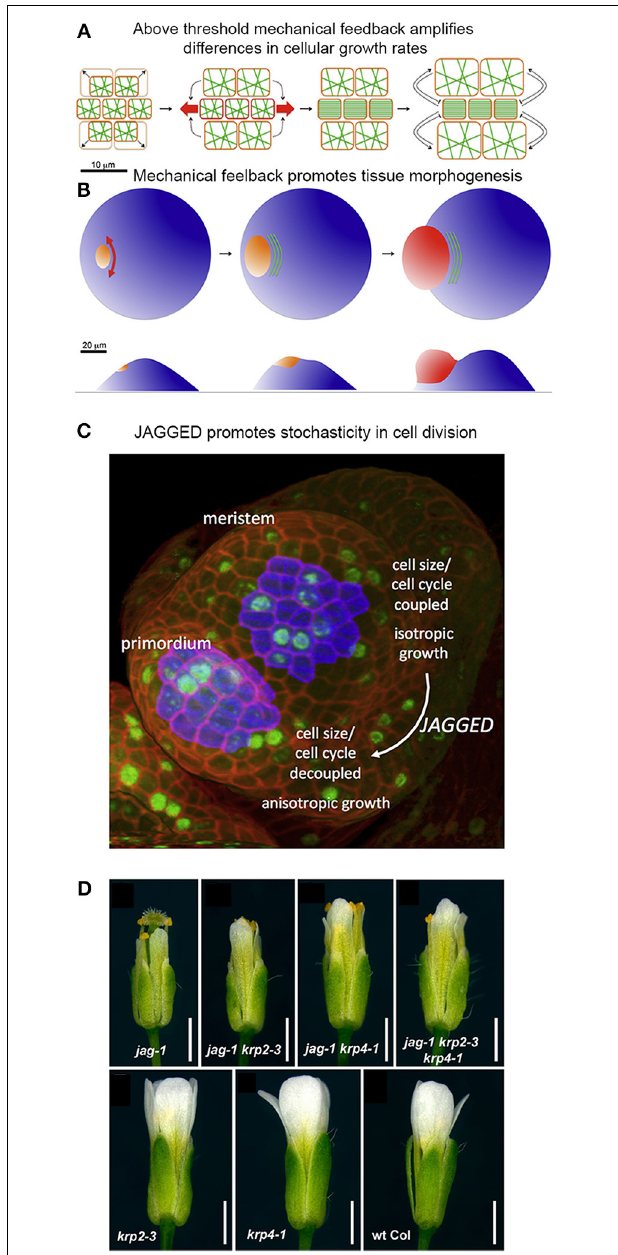
FIGURE 9 | Mechanical stress and genetics can enhance stochasticity to promote heterogeneous growth. (A,B) Mechanical feedback loops can amplify variability in cellular growth rates to direct morphogenesis. (A) Microtubule (green) orientation is initially random when little mechanical force is exerted on cells. If some cells grow more rapidly than their neighbors (top and bottom cells in the left panel), they exert a force on the slower growing cells (in the middle). Once force surpasses a particular threshold (red arrows), microtubules will re-orient in a parallel manner to induce anisotropic growth that resists the mechanical stress. This further amplifies differential growth between neighboring cells. (B) On the organ scale, mechanical stress can amplify differences in growth rates to promote tissue morphogenesis. The shoot apical meristem (blue) endures increased mechanical stress and anisotropic growth in the peripheral zone, where the organ primordium is emerging (orange to red). Cortical microtubules